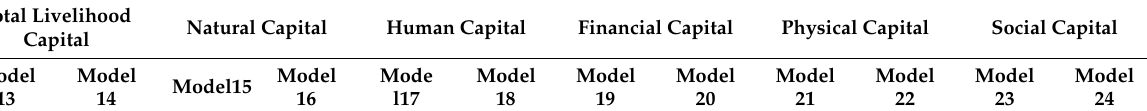
Table 6. The dynamics regression model result of the impact of the fiscal expenditure structure on livelihood